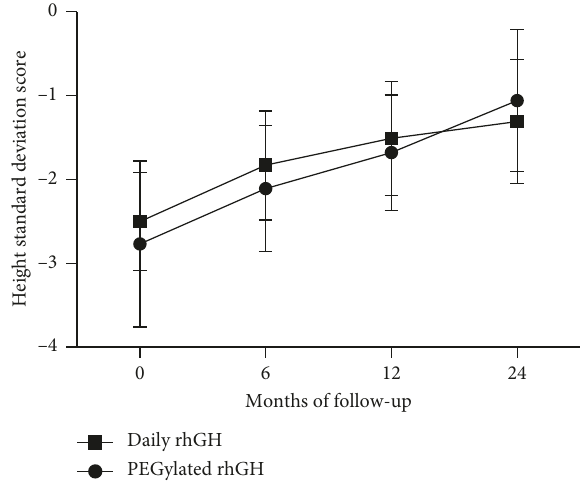
Figure 4: Height SDS over time in GHD children treated with PEGyated rhGH (weekly) or daily rhGH (daily) for 24months. Values represent mean ± SD.